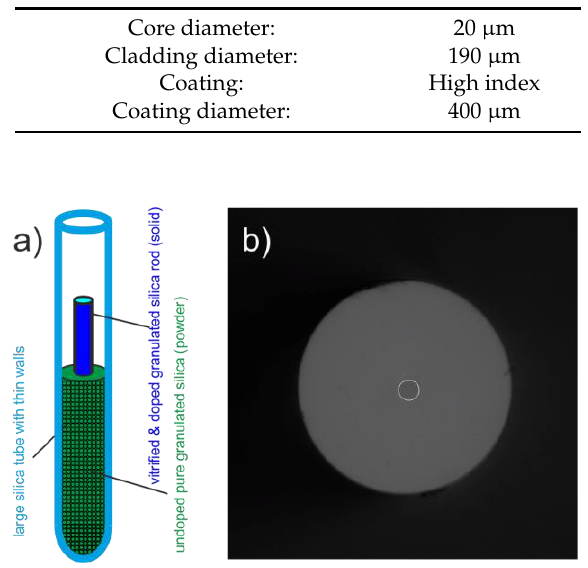
Figure 13. Single-clad (SC) LMA fiber derived from sol-gel granulated silica method: ( a ) preform assembly; and ( b ) fiber geometry: microscope image (white ring indicates the core) [7].